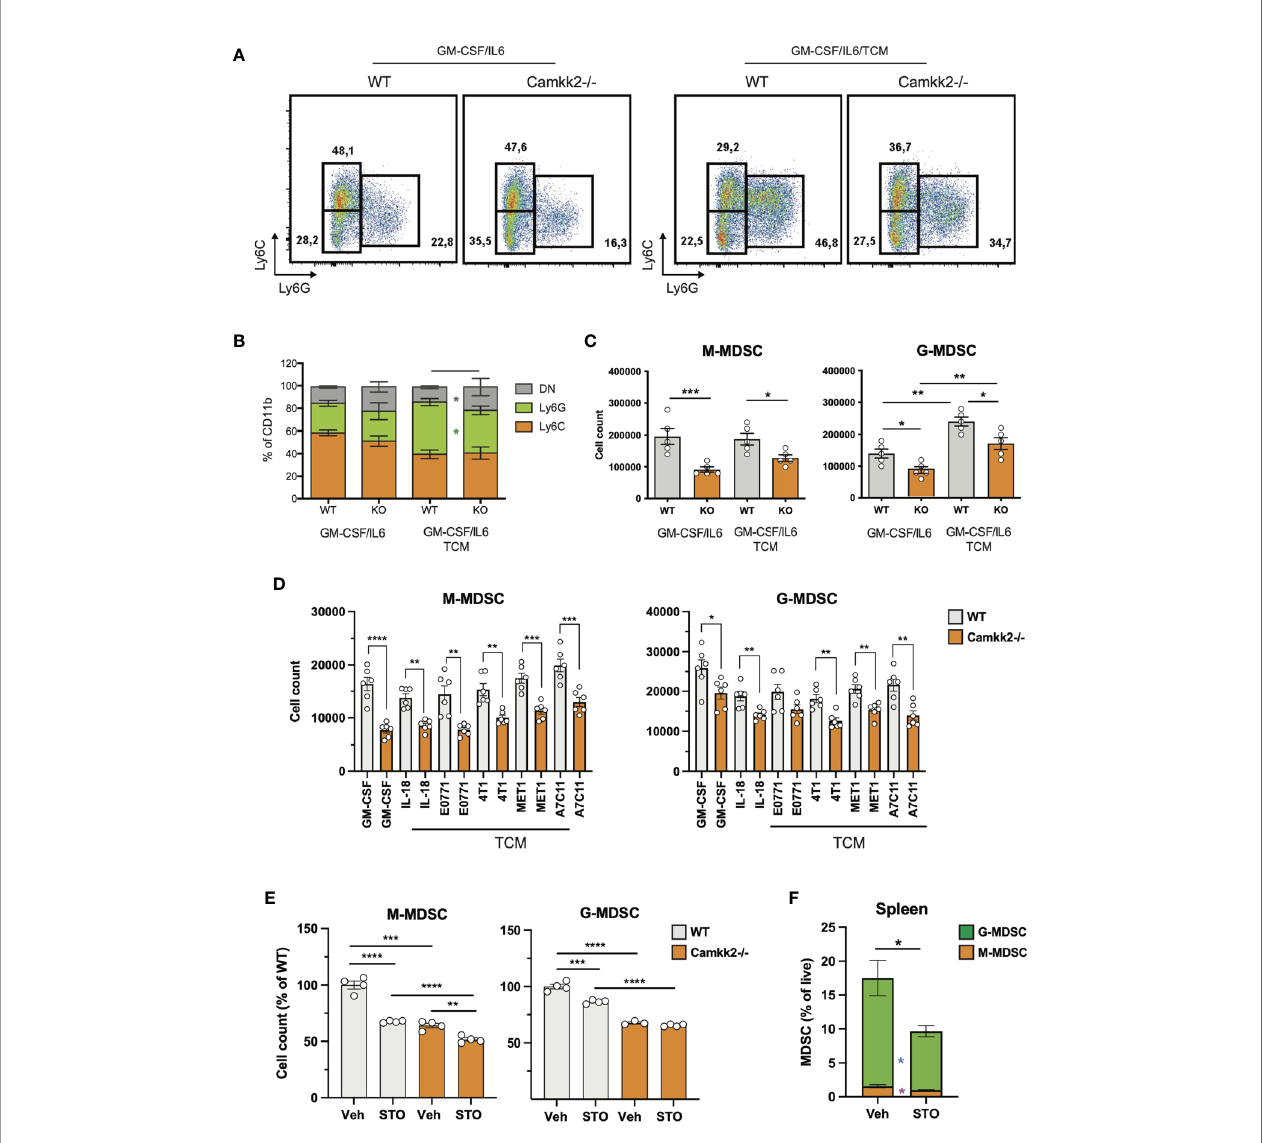
FIGURE 3 | Deletion of Camkk2 impairs MDSC expansion in vitro. Bone marrow nucleated cells from WT and Camkk2 -/- mice were cultured with cytokines in the absence or presence of E.G7-OVA tumor conditioned medium (30% v/v). After 4 days, cells were collected, stained, and analyzed by fl ow cytometry. (A) Gating strategy to identify MDSCs and representative dot plots. (B, C) Percentage and absolute number of MDSCs. (D) . Yield of MDSC generated with GM-CSF in the presence of the cytokines and mammary tumor cells-TCM (E) Yield of MDSC generated in the presence of STO-609 (2uM). (F) EG7-OVA cells were inoculated SC in the fl ank of WT and Camkk2 -/- mice. When the tumor where established, mice bearing tumors of comparable size (400-600 mm 3 ) were treated with STO-609 (40 m moles/Kg, IP at 48 hours interval, total 3-doses) and euthanized. Spleen were then removed and the frequency of MDSC were determined by fl ow cytometry. *, **, *** and **** refer to p<0.05, 0.01, 0.005, and 0.001,